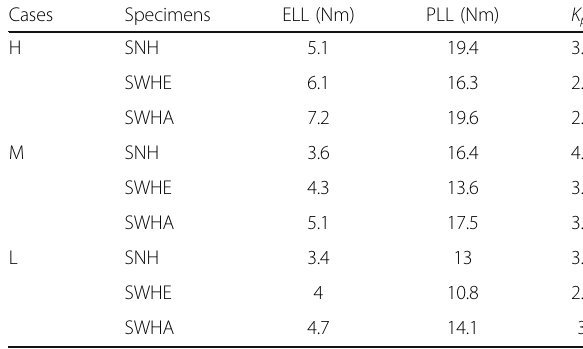
Table 8 Factor K p from 3D finite element